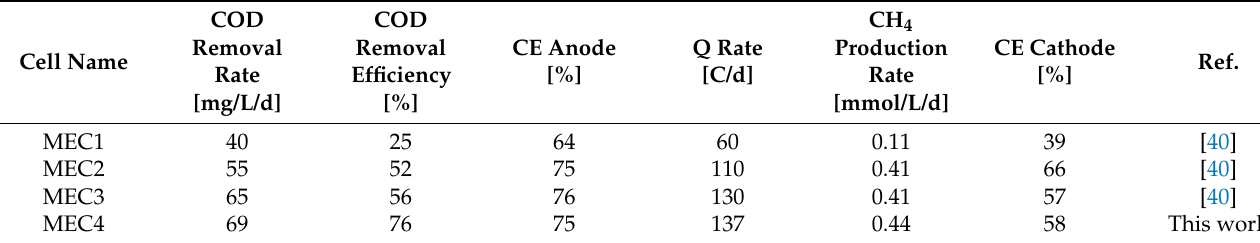
Table 1. Comparison of following monitored parameters in MEC1–4: COD removal rate, COD removal efficiency, CE anode, Q rate, CH 4 production rate, and CE